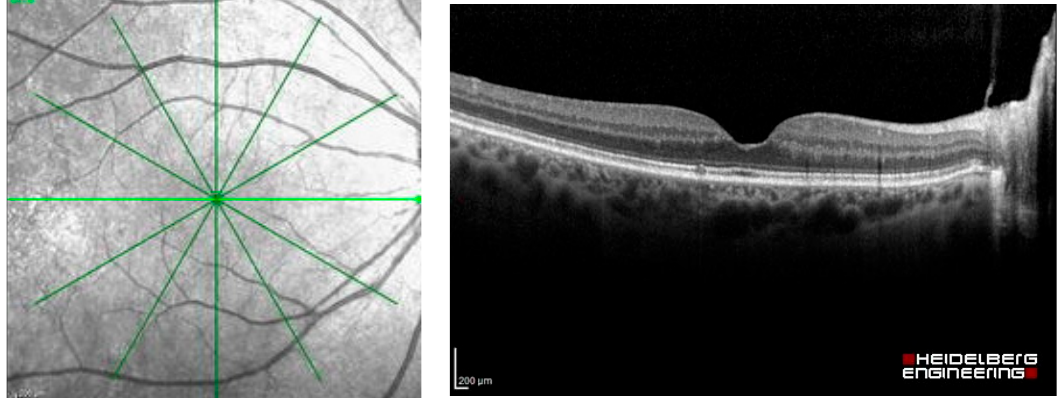
Figure 2. Radial OCT scan of a retina and example of an OCT image of the light green line. Table 1. The distribution of OCT images assigned to each class.